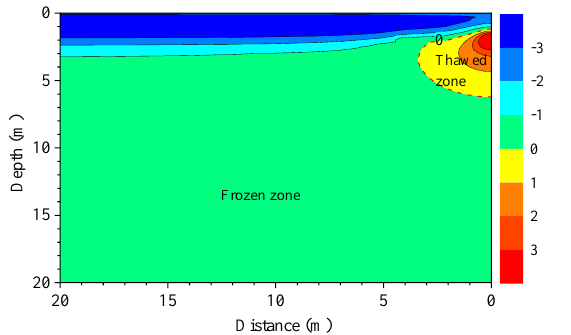
Figure 6. Geo-temperature distributions around the buried pipeline on January 15 in the 6th year. (Units: °C).